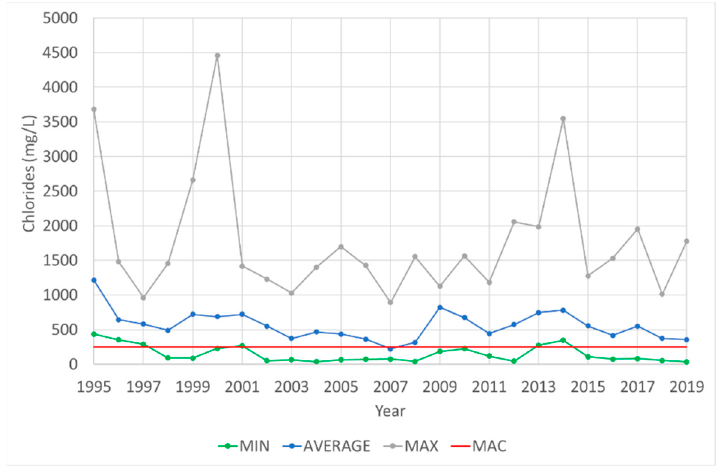
Figure 2. Minimum, average, and maximum annual concentrations of chlorides in the Boljkovac water supply facility (MAC—maximum allowed concentration for chlorides for drinking water).